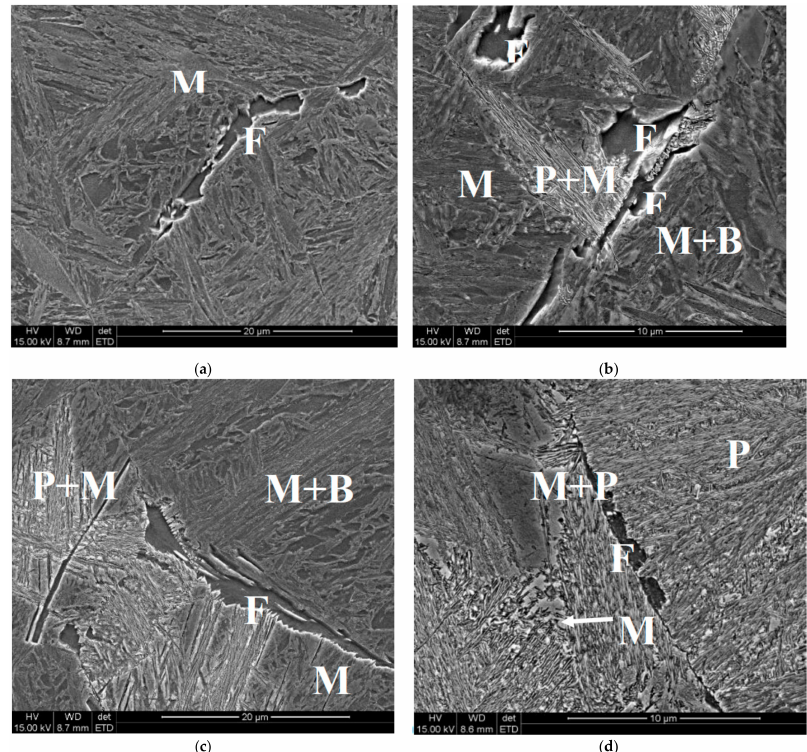
Figure 4. Microstructures of the samples after holding at the temperature of 560 ◦ C for 600 s ( a ), 1200 s